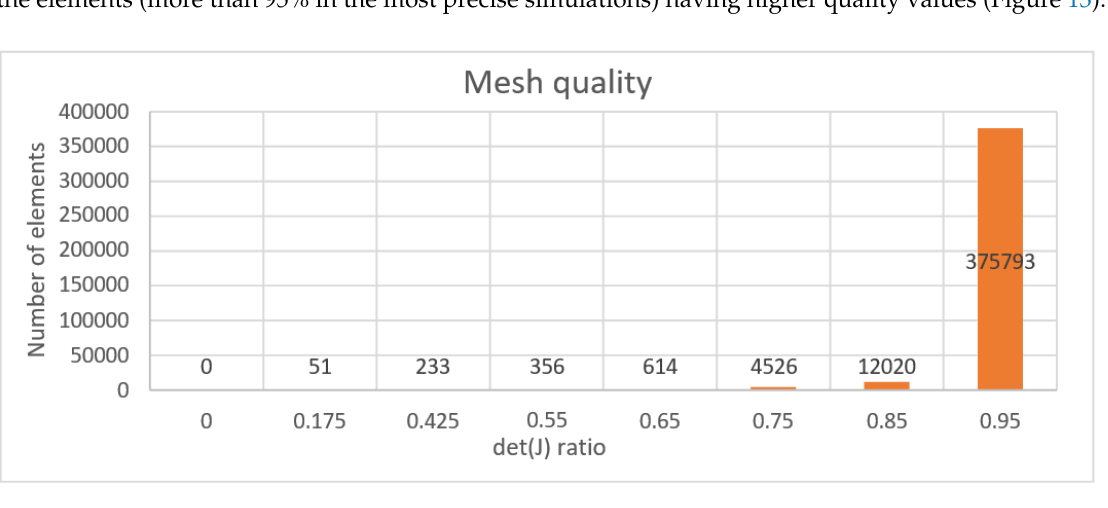
Figure 14. Left: Highly distorted basic mesh with many elements with det(J) ratio ≤ 0 (red elements). Right: Corrected high-quality mesh with the same geometry, ensuring stable and accurate CFD calculations. 4. Results 4.1. Turbine Design Preliminary Results As illustrated in Figure 15, the low difference in efficiency for small-aspect ratio blades for prismatic and 3D blades is validated, as it is in the order of 3%. After verifying this hypothesis with